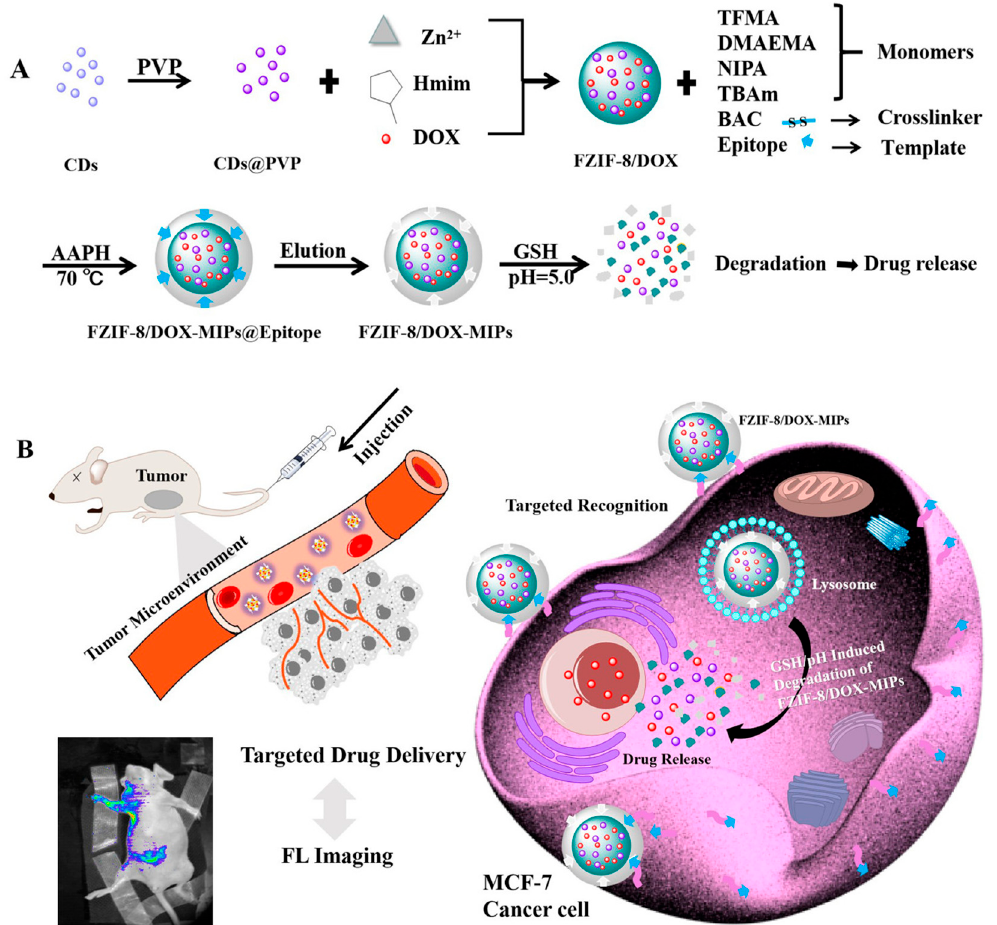
Figure 11. ( A ) Synthesis and GSH/pH dual stimulation degradation route of FZIF-8/DOX-MIPs; ( B ) Schematic illustration of targeted imaging and GSH/pH-responsive drug delivery of FZIF-8/DOX-MIPs. Reproduced with permission from Qin et al. [141].